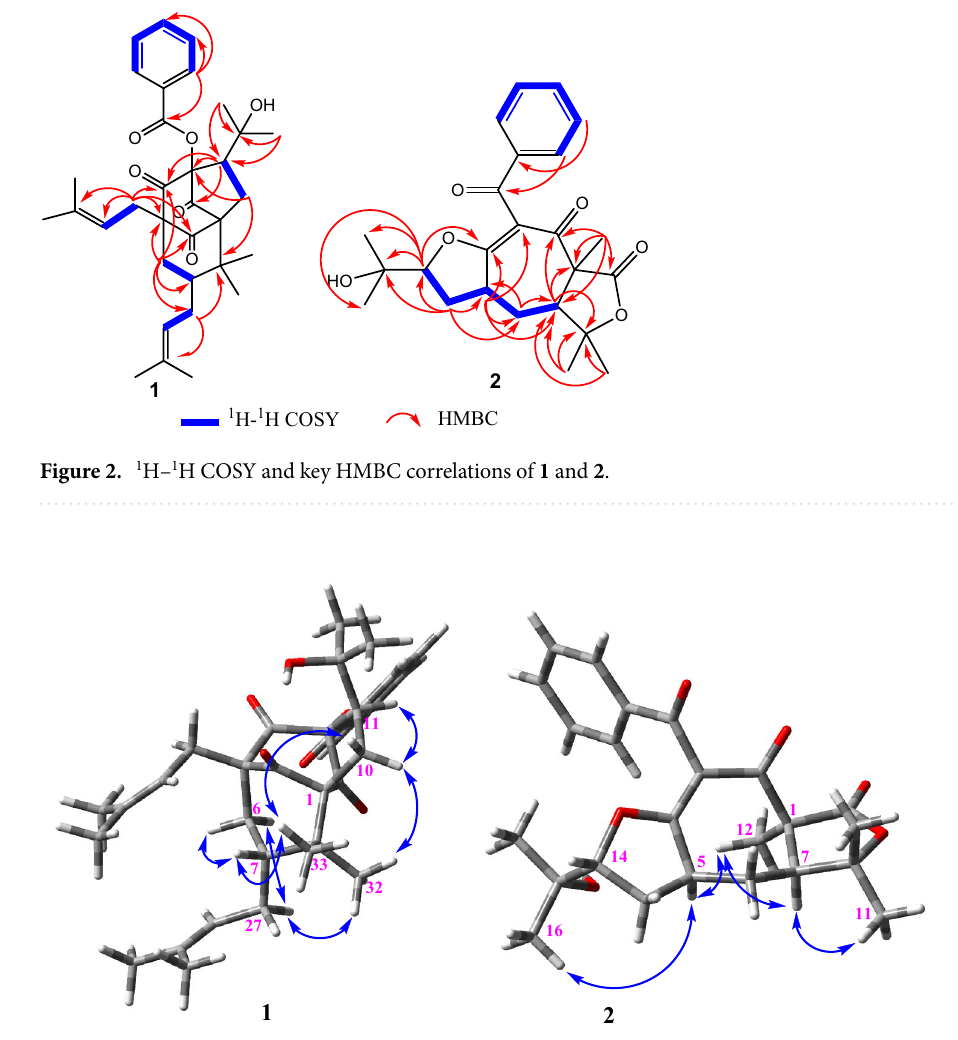
Figure 3. NOESY correlations of 1 and 2 .